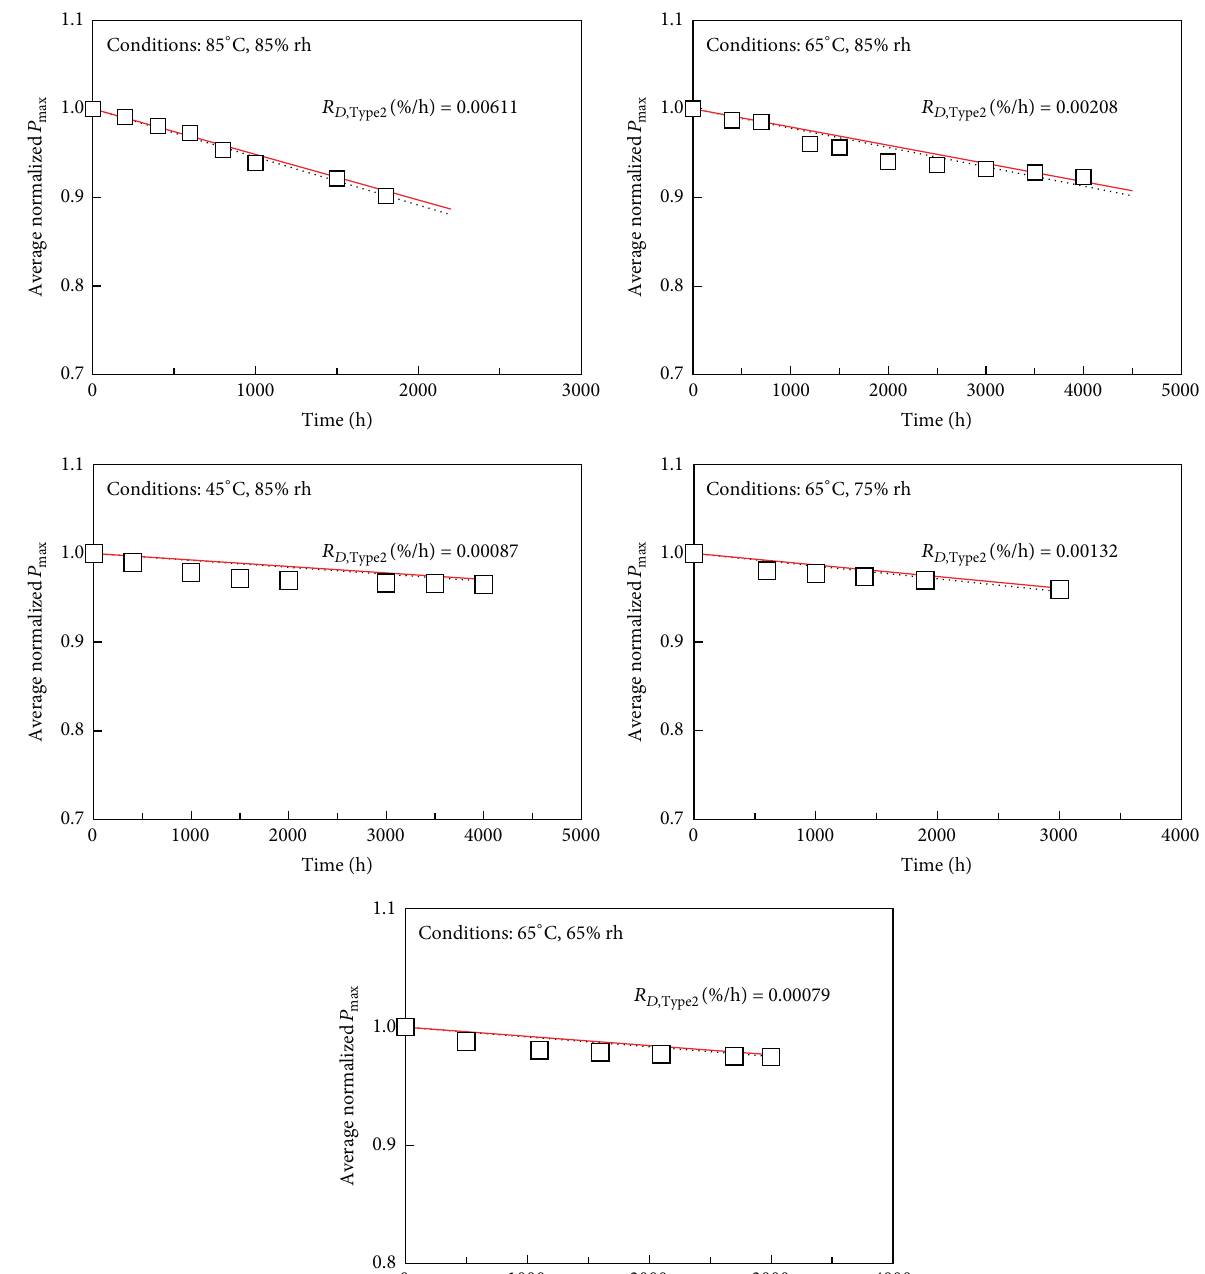
Figure 4: Average normalized 𝑃 max of Type 2 as a function of time. ◻ shows the measurement data, dotted line (black) shows the predicted degradation rate obtained using (1), and straight line (red) shows the predicted degradation rate obtained using (2).